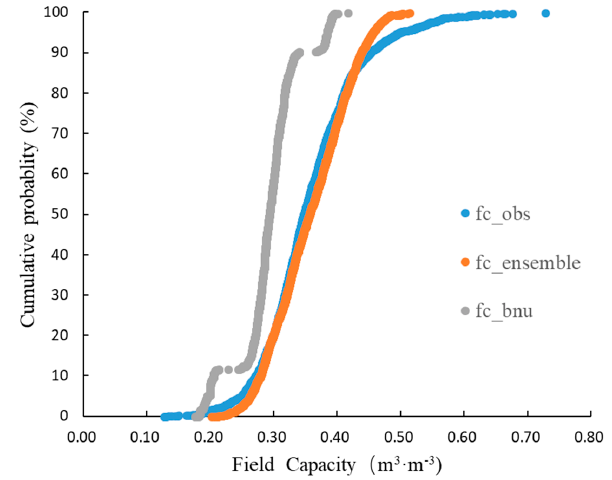
Figure 11. Cumulative distribution function of in situ, ensemble, and BNU field capacities. The fc_obs, fc_ensemble, and fc_bnu represent in situ, ensemble, and BNU field capacities, respectively.